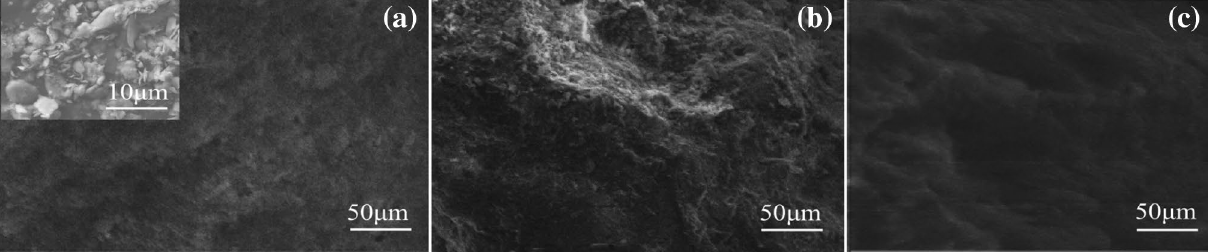
Fig. 1 a – c FESEM images for the samples S2, SK2, and SKC2, respectively. An inset in a shows a closer view of the mesoporous arrangements